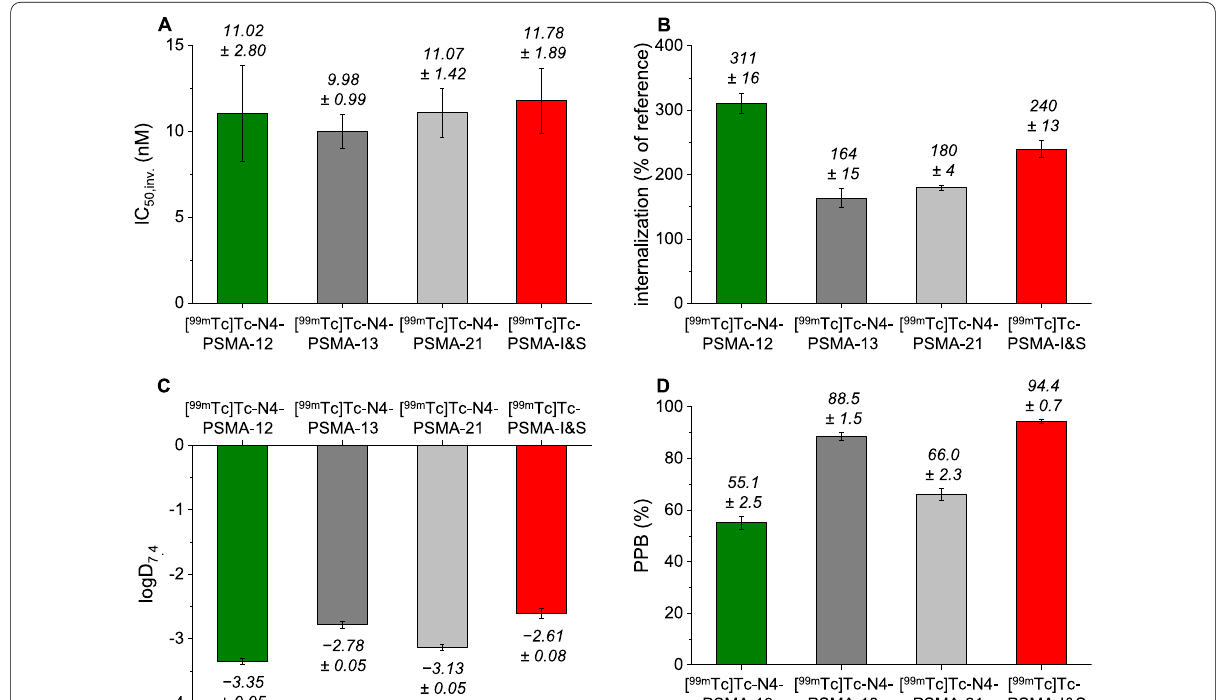
Fig. 2 In vitro characterization of [ 99m Tc]Tc‑N4‑PSMA‑12, [ 99m Tc]Tc‑N4‑PSMA‑13, [ 99m Tc]Tc‑N4‑PSMA‑21 and [ 99m Tc]Tc‑PSMA‑I&S: A Binding affinity to PSMA (IC 50,inv. (nM), 1 h, 4 °C, n 3); B PSMA‑mediated internalization (1 h, 37 °C, (% of the reference [. 125 I]IBA‑KuE), n = log D 7.4 ( n ‑octanol/PBS, pH 7.4, n 8); D binding to human plasma (PPB) (incubation at 37 °C for 30 min, determination via ultrafiltration (%), n =